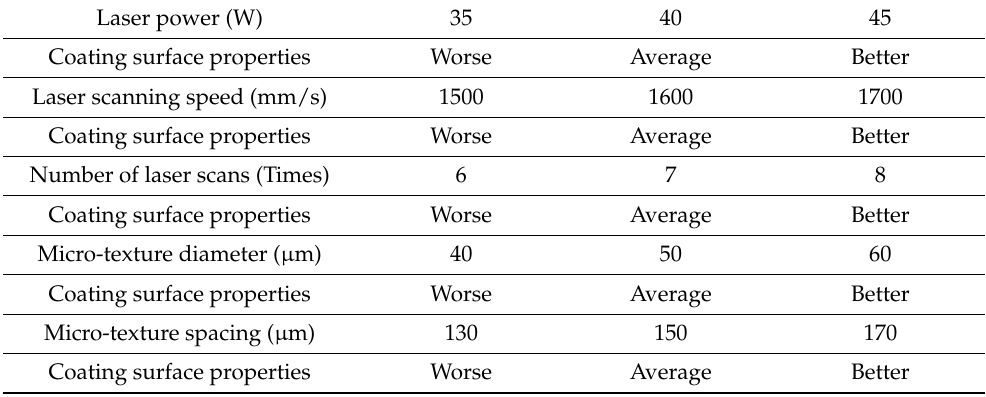
Table 3. Influence of micro-texture parameters on surface properties. Laser power (W) Coating surface properties Worse Average Better Laser scanning speed (mm/s) 1500 1600 1700 Coating surface properties Worse Average Better Number of laser scans (Times) Coating surface properties Worse